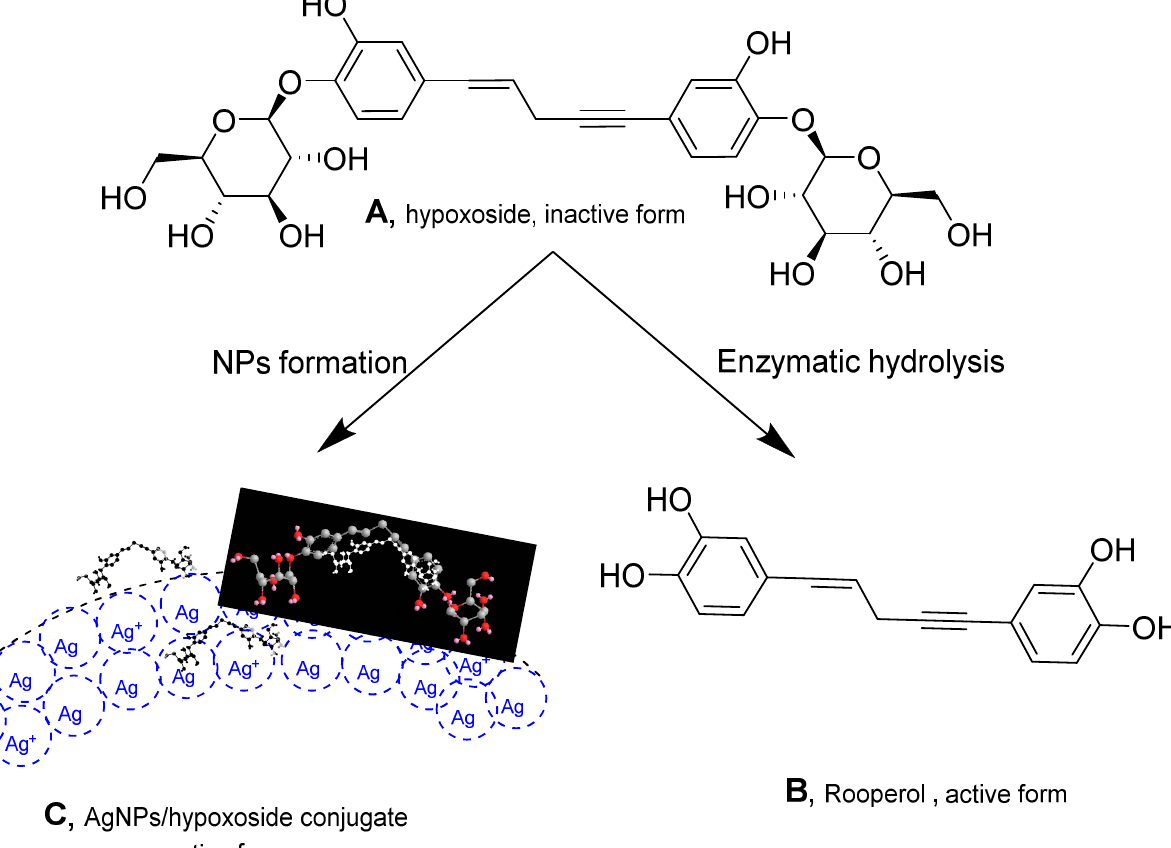
Figure 1. Structure of hypoxoside ( A ) and rooperol ( B ) upon conversion using β-glucosidase enzyme and hypoxoside/AgNPs conjugate ( C ).